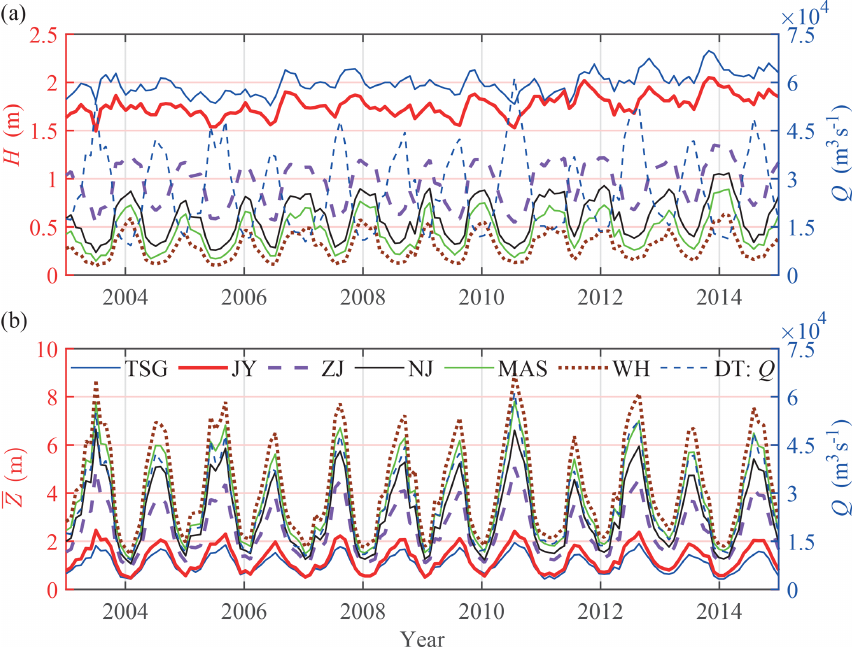
Figure 2. Temporal (monthly averaged) variations of the observed tidal range, H , (a) and residual water level, Z , (b) at different gauging stations along the Yangtze River estuary and the observed river discharge at DT.